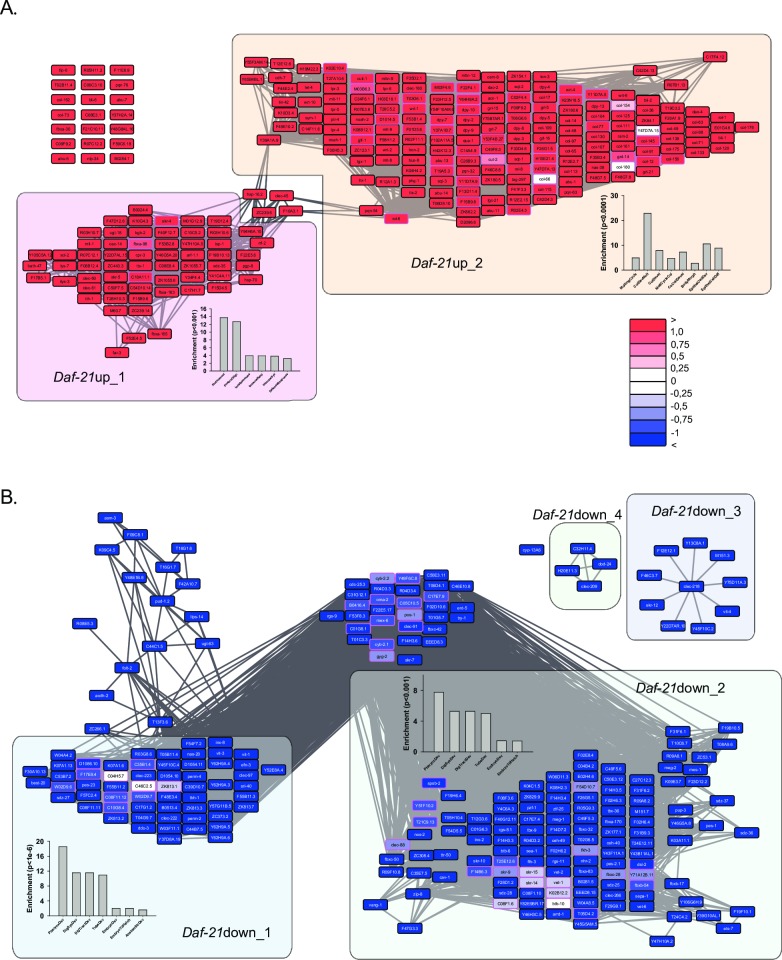
Transcriptional networks affected by RNAi against daf-21.Networks for upregulated (A) and downregulated (B) genes after Hsp90-depletion. The networks were constructed as described in the Materials and Methods section. The color code uses four shadings of blue and red to indicate the expression differences with darkest blue being log2(DiffExp) < -1, lightest blue being log2(DiffExp) < -0.25, darkest red being log2(DiffExp) > 1 and lightest red being log2(DiffExp) > 0.25. In between 0.25 and -0.25 the nodes are white as indicated in the legend. Large clusters have been subjected to GO-term enrichment analysis and the results are depicted adjacent to the respective cluster in the network figure.